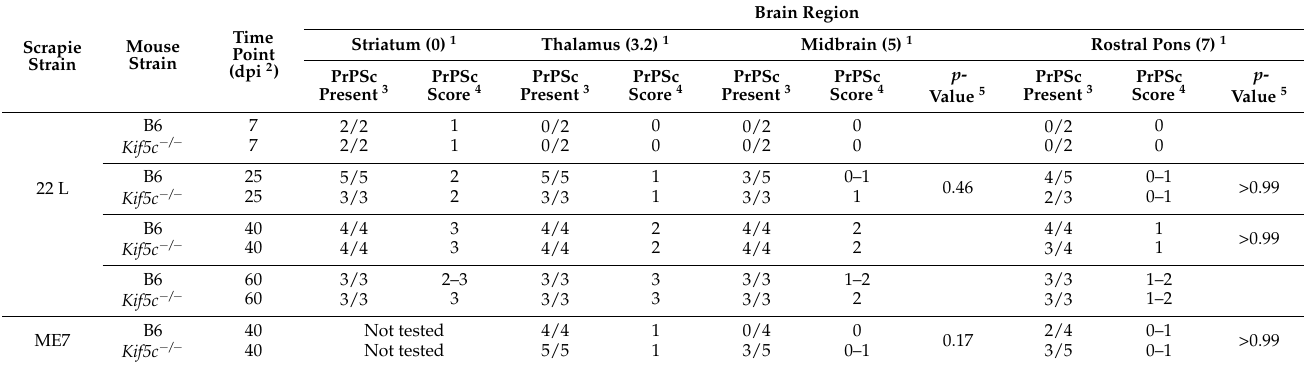
Table 1. Early spread of infectious prions (PrPSc) in brains of C57BL/6 and Kif5c − / − mice following stereotactic inoculation.